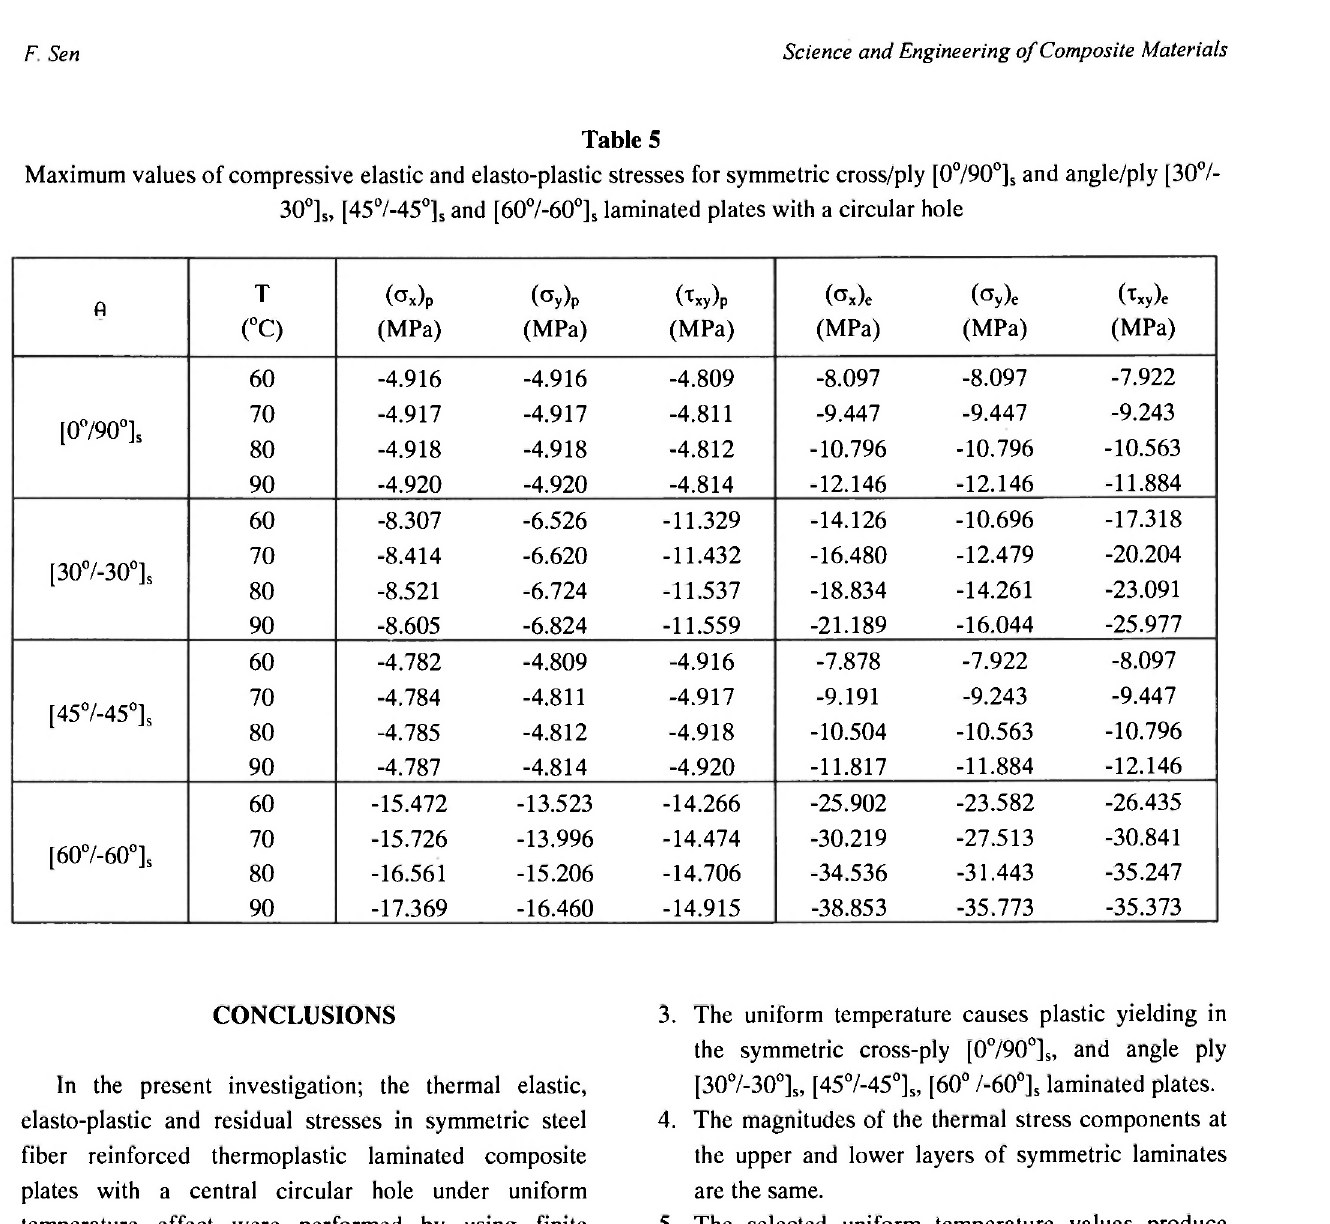
Maximum values of compressive elastic and elasto-plastic stresses for symmetric cross/ply [0°/90°]